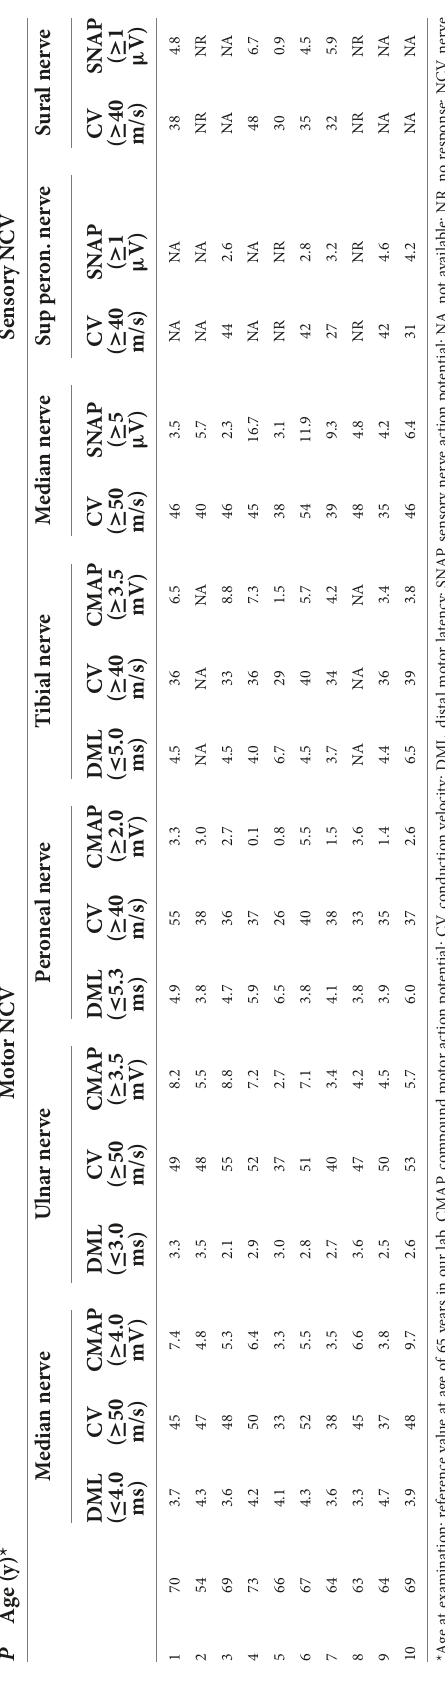
microscopy revealed filamentous inclusions in the nuclei of urinary neutrophils ( Figures 5A–C ) or monocyte ( Figures 5D– F ) in the